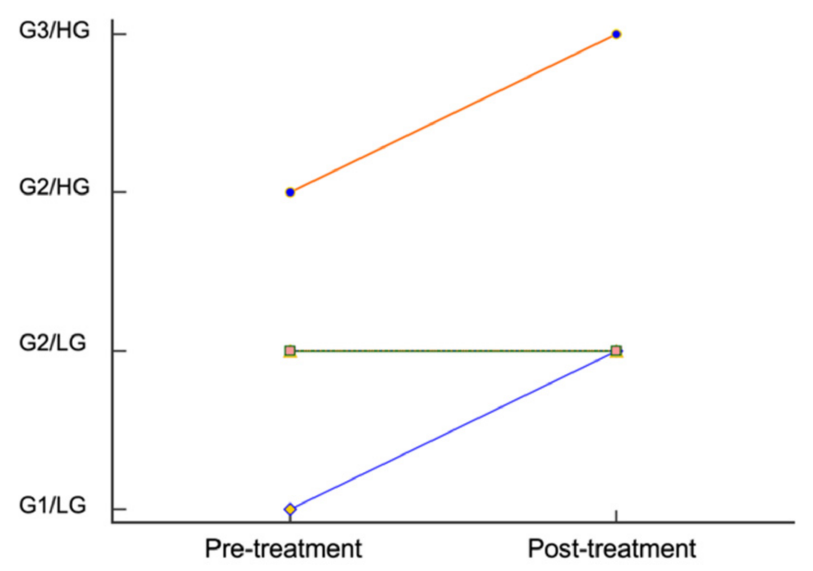
Figure 1. Pre- and post-treatment tumor grade classifications. The classification for nine G2/LG tumors did not change. The Patnaik classification, but not the Kiupel designation, increased for two tumors following treatment with